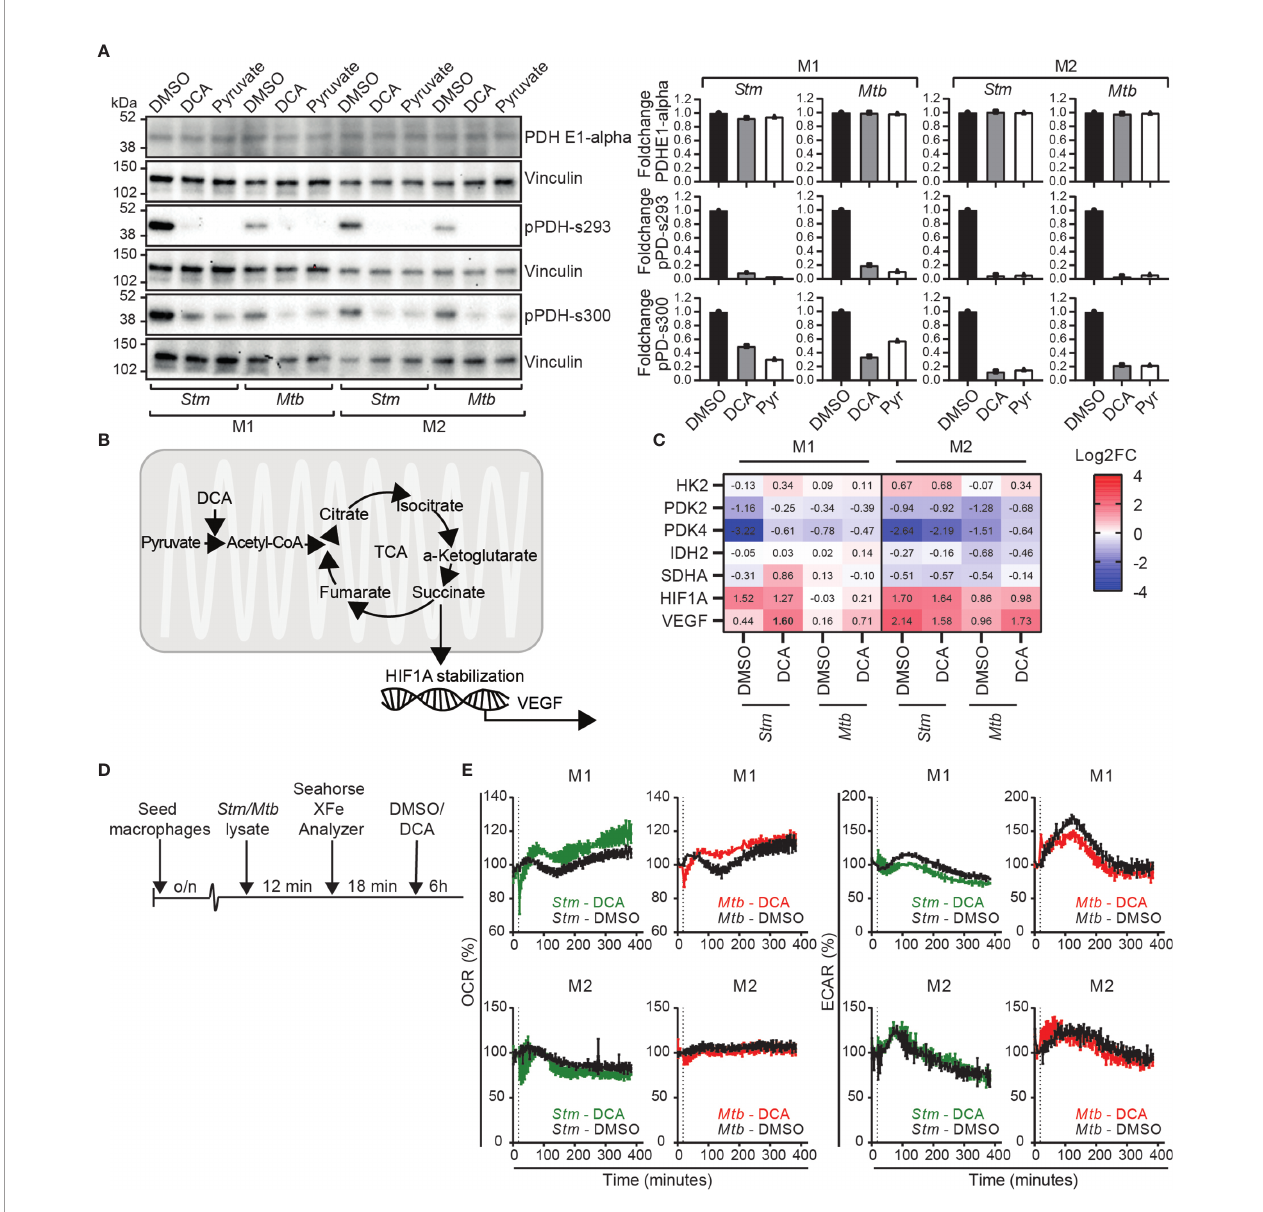
FIGURE 4 | DCA activated the PDC in human macrophages and induced a metabolic shift from glycolysis to OXPHOS in M1. (A) Western blot showing total PDH (PDH-E1 a ) and PDH phosphorylation at serine residues 293 and 300 at 4 hours post infection in Stm- or Mtb -infected M1 and M2 treated with DCA (10 mM), pyruvate (10 mM) or vehicle control DMSO (0.1% v/v). Shown is a representative blot from one out of three independent experiments (left panel) and the band intensities were quanti fi ed using Fiji/ImageJ, normalized to loading control vinculin and shown as fold change (FC) against DMSO (right panel). (B) Schematic representation of pyruvate metabolism linked with the TCA cycle and HIF-1 a stabilization. (C) mRNA expression levels were quanti fi ed by Fluidigm qPCR using GAPDH as the housekeeping control gene. Stm - or Mtb -infected M1 and M2 were treated for 4 hours with DCA (10 mM) or vehicle control DMSO (0.1% v/v). Shown are the median ± interquartile range log2FC relative to uninfected macrophages of four donors. Differences were signi fi cant by a paired t-test between DMSO and DCA and are shown in bold. (D) Schematic representation of the experimental setup used in (E) . (E) The ECAR and OCR were determined over time (0-400 min) in Stm or Mtb -lysate stimulated human macrophages using the Seahorse XF96 analyzer. M1 and M2 were stimulated with 10 µg/ml Stm or Mtb lysate for approximately 12 minutes before the fi rst measurement. The vertical dashed line indicates DCA ( fi nal concentration 10 mM) or DMSO (at equal v/v) injection at t=18 minutes. Data represent the mean ± standard deviation of triplicates from one representative donor out of four